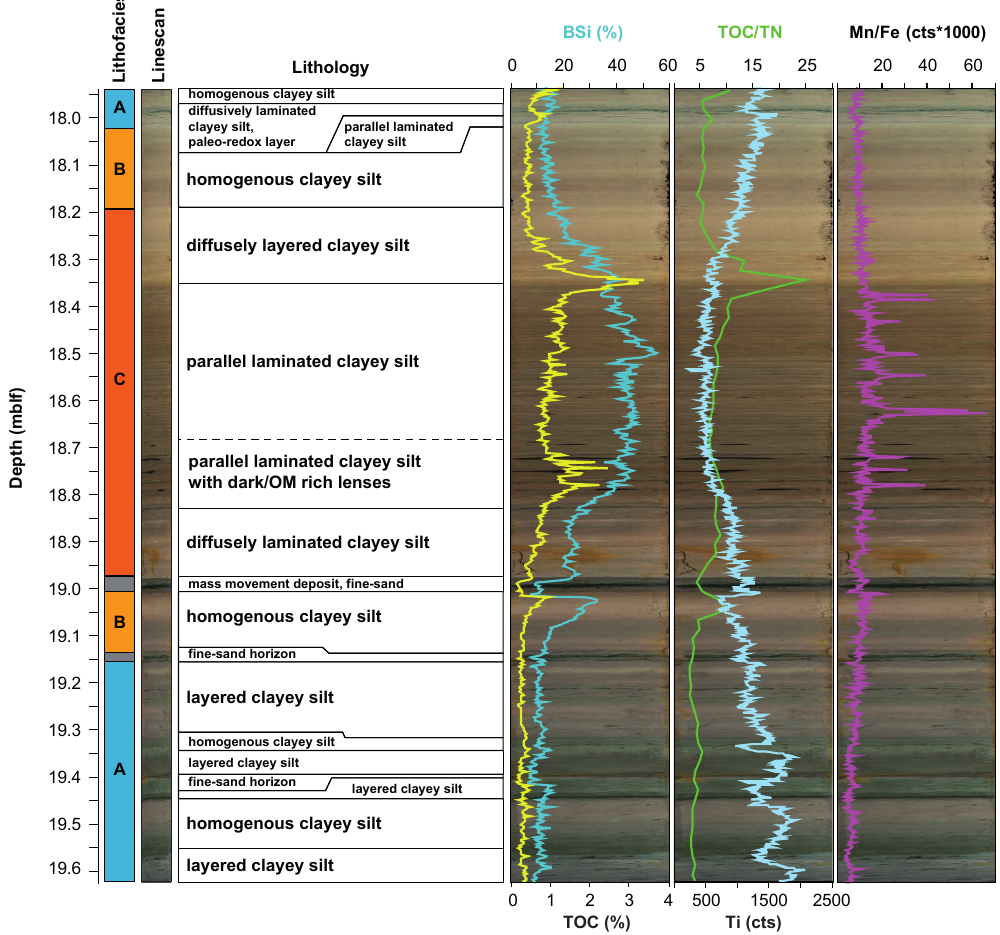
Fig. 2. Lithofacies classification, color linescan, lithological description and geochemical indicators (BSi = biogenic silica; TOC = total organic carbon; TN = total nitrogen; cts = counts) underlain by stretched line scan images for the interval 17.94–19.63m from the core composite of ICDP Site 5011-1 comprising the MIS 12/11 transition and MIS